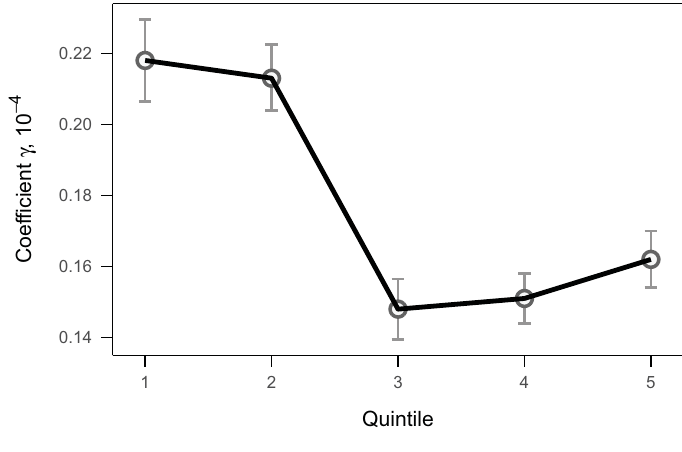
Fig 4. The regression estimates of the seven-day PM 10 concentration by quintile. The estimated coefficients of the seven-day concentration of PM 10 on the likelihood of respiratory disease using the whole sample are shown with the 95% error bars for each quintile. The errors are based on the robust standard errors, clustered by individual.